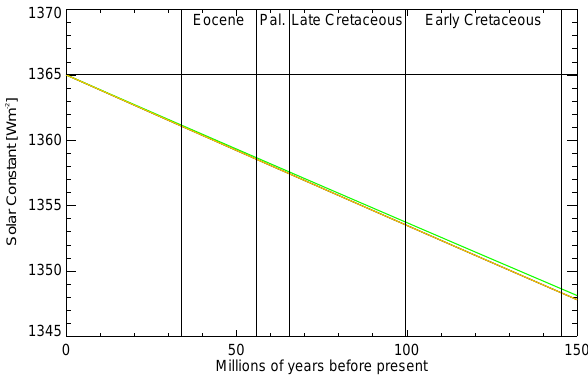
Figure 2. The values of solar constant since the earliest Cretaceous, calculated from Gough (1981) and used for the CPE simulations in this paper (green line), and from Caldeira and Kasting (1992) (orange line). Horizontal line shows the modern